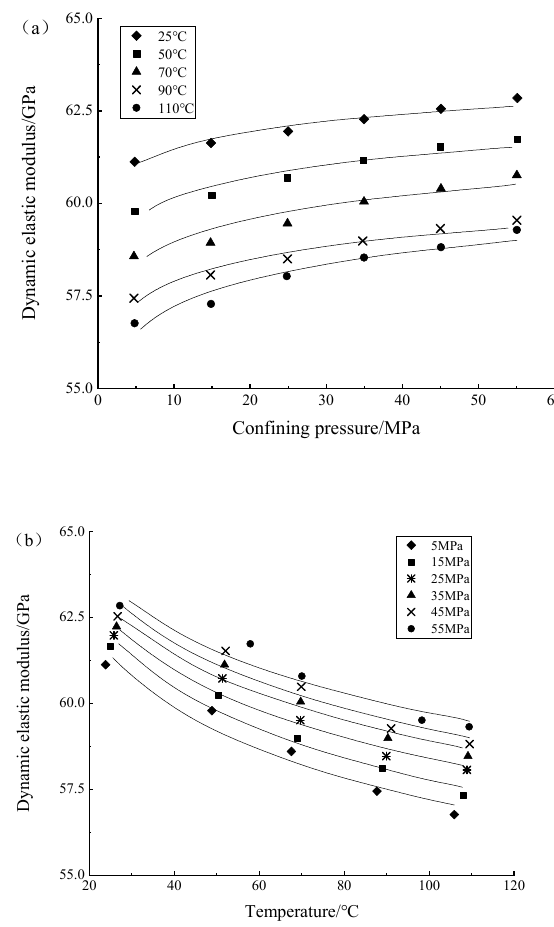
Figure 2. Variations in dynamic elastic modulus of specimen #9 under the conditions of different confining pressures and temperatures: ( a ) variation in dynamic elastic modulus with confining pressure; ( b ) variation in dynamic elastic modulus with temperature .